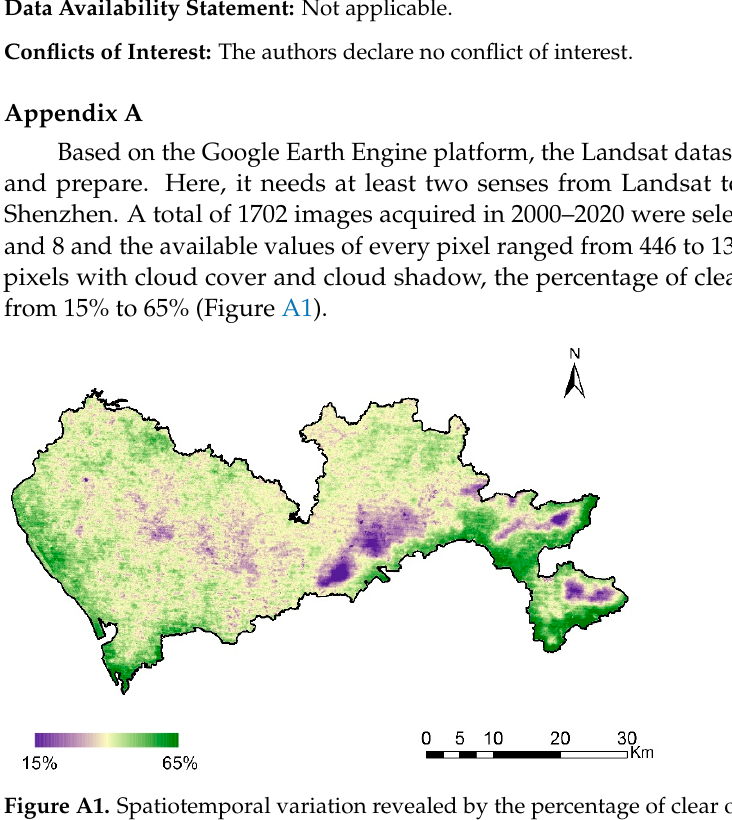
Figure A1. Spatiotemporal variation revealed by the percentage of clear observations in 2000–2020 acquired from Landsat 5, 7, and 8.